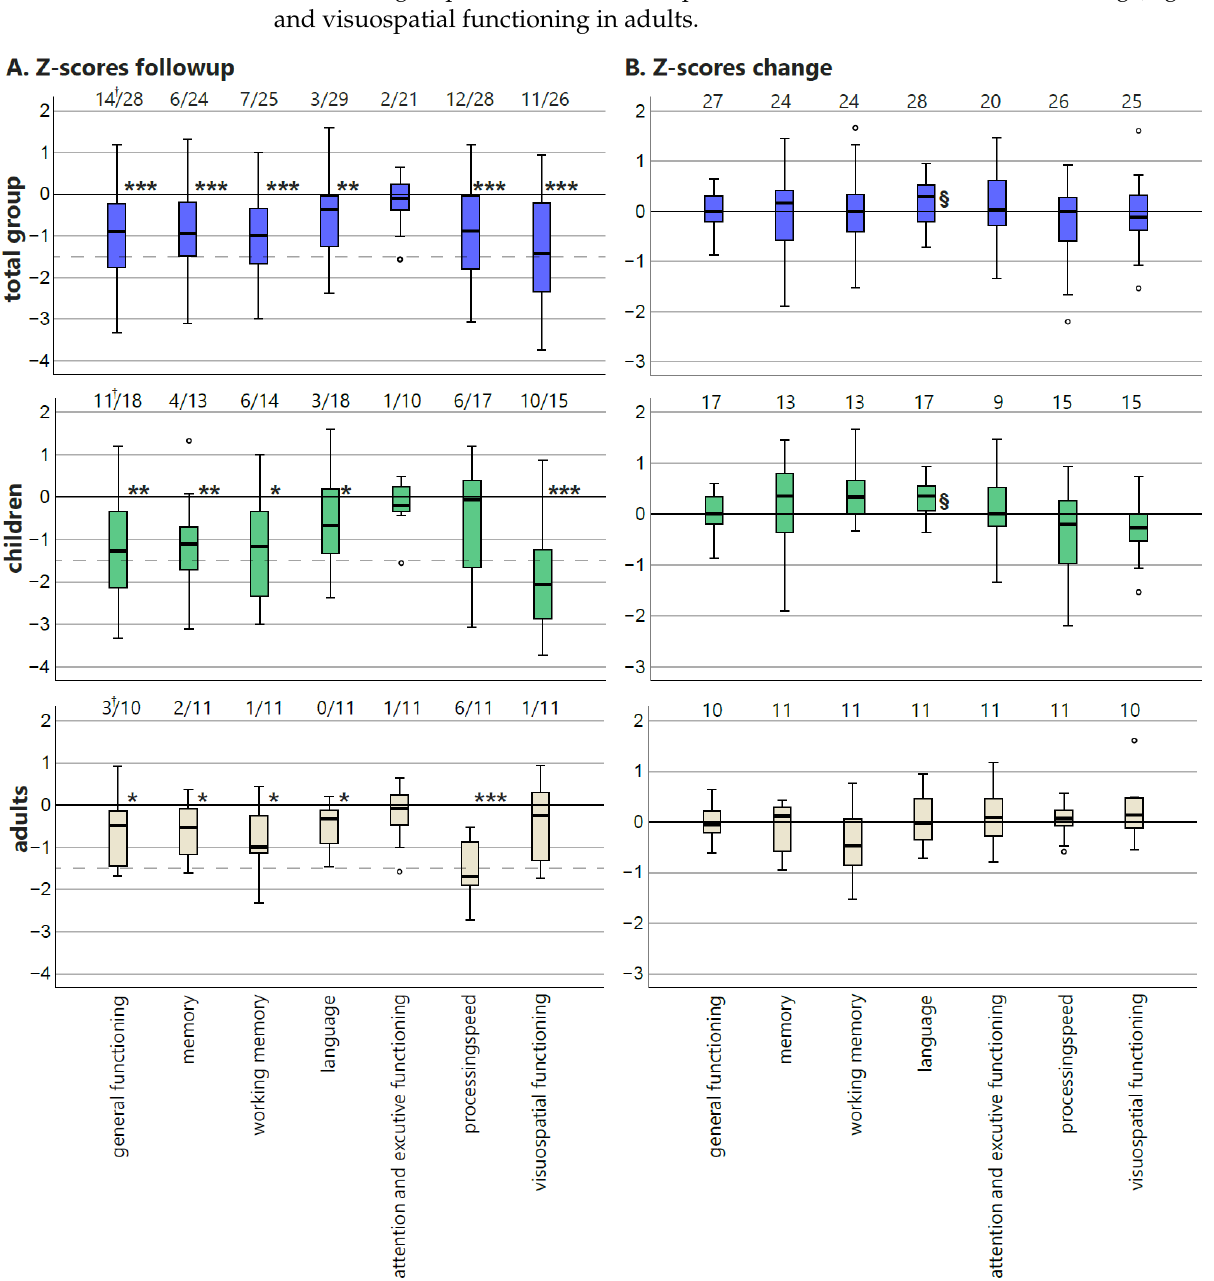
Figure 4. ( A ) Z -scores of neurocognitive tests at follow-up for the total group for children and adults separately for all seven cognitive domains. The numbers represent the amount of patients with a z -score below − 1.5 SD (dashed line) compared to the total number of patients with a valid domain score per group. Scores significantly different from the population mean (one-sample t -test) are noted with * ( p < 0.05), ** ( p < 0.005), and *** ( p < 0.0005). ( † ) Two pediatric patients could not understand the tests due to insufficient cognitive functioning. These patients were given a “ deficit ” score for general functioning but could not be included in the box plots. ( B ) Change in z -score between follow-up and baseline. A higher score indicates an improvement. The numbers represent the amount of valid test scores per cognitive domain; ( § ) significant improvements in z -score ( p ≤ 0.05).